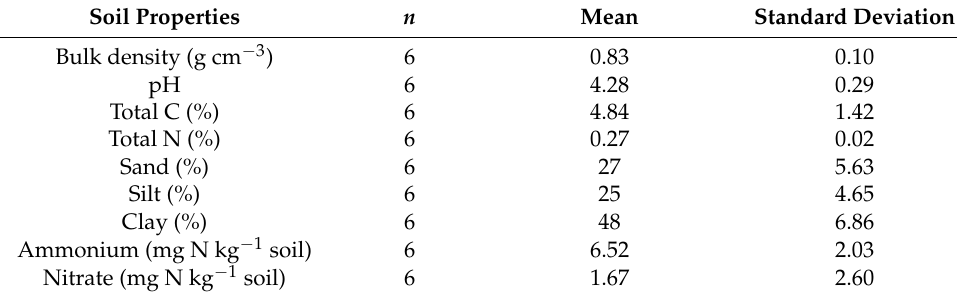
Table 1. Bulk soil properties at the study